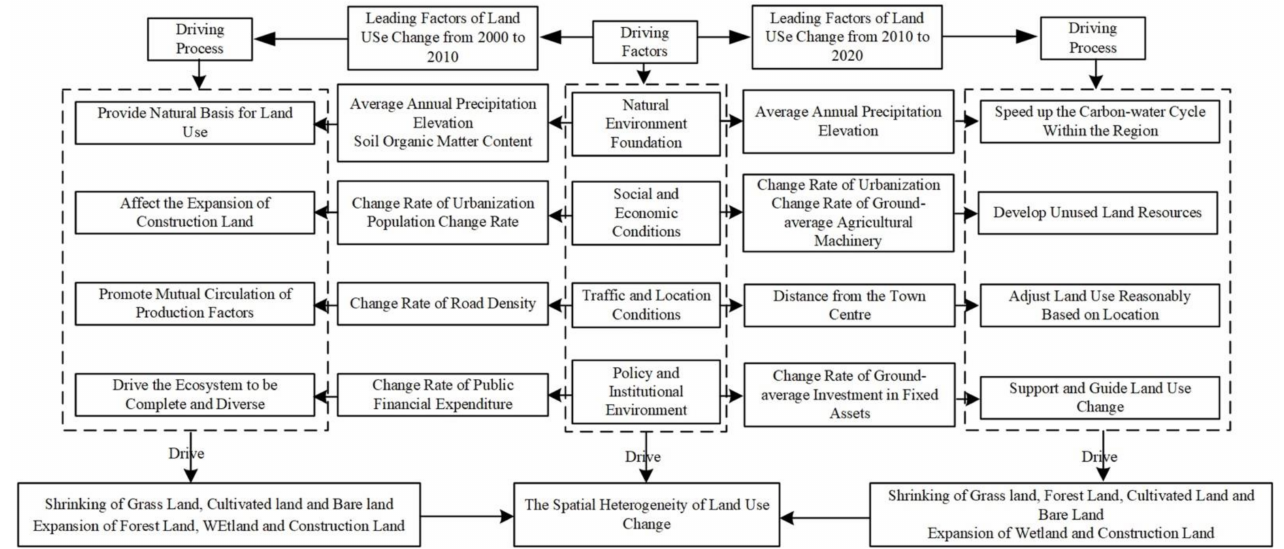
Figure 6. The land use change driving mechanism in typical areas of the Yellow River